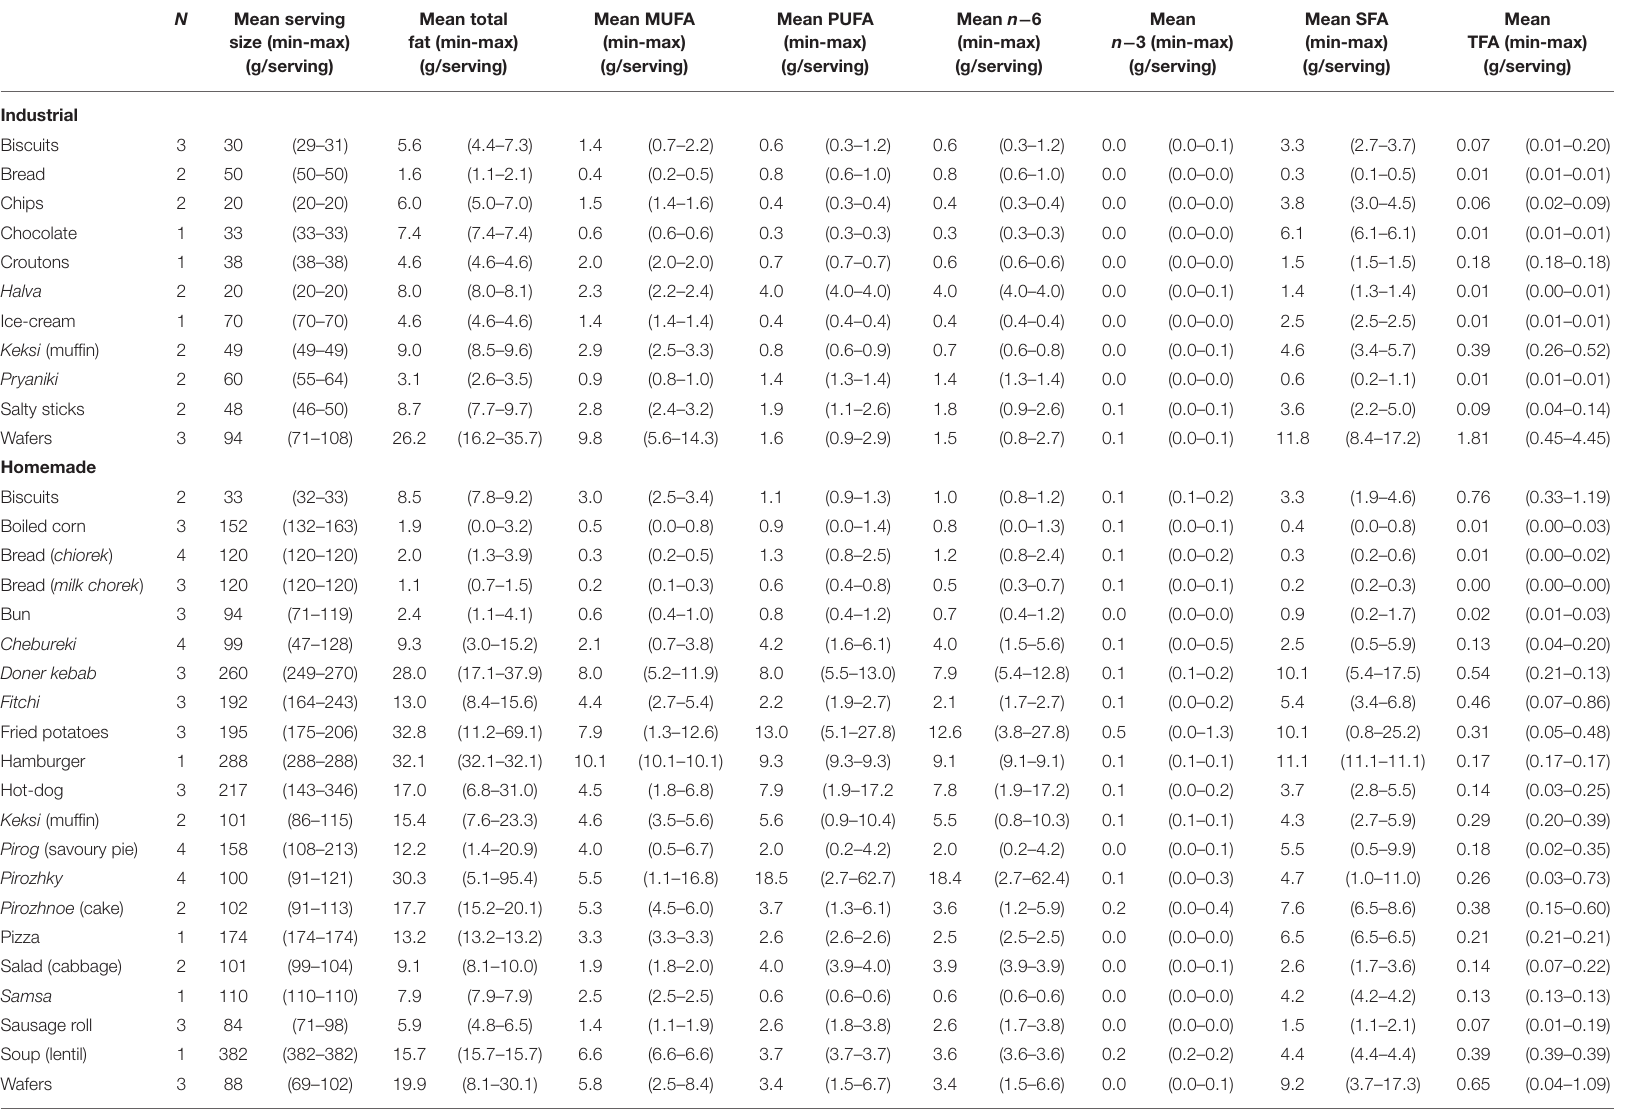
SFA, saturated fatty acids; MUFA, monounsaturated fatty acids; PUFA, polyunsaturated fatty acids; TFA, trans fatty